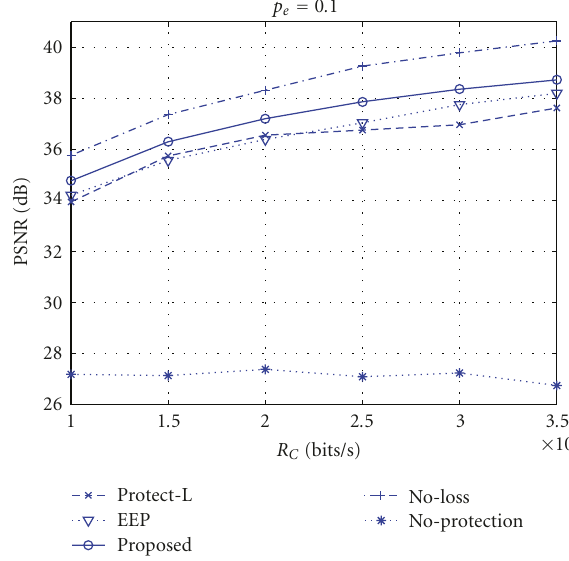
Figure 24: Results for p e = 0 . 10 for “Soccer” video. p e = 0 . 2